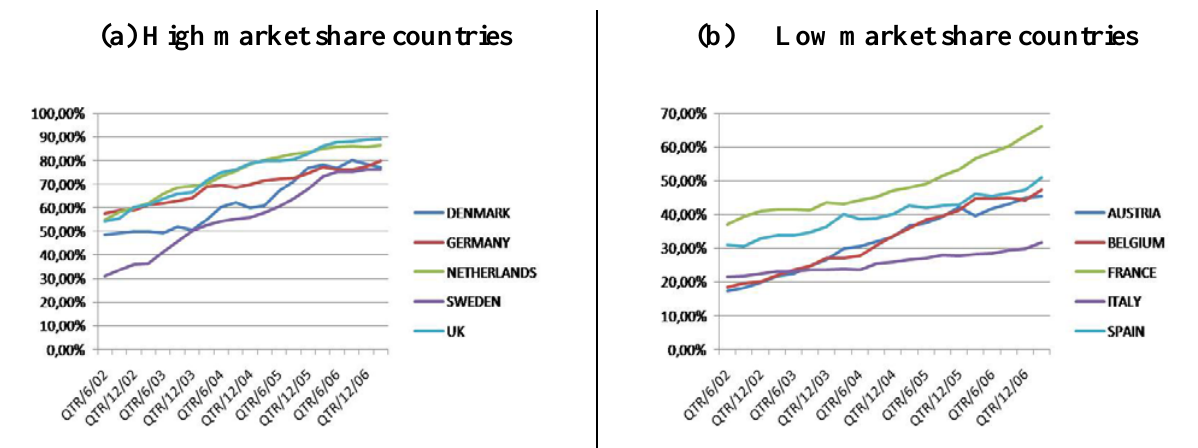
Figure 1. Evolution of generic medicine market